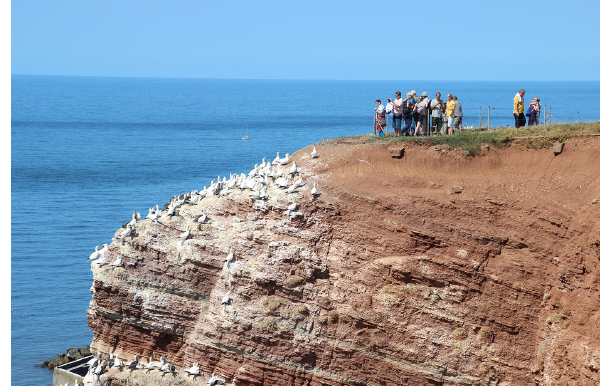
Figure 1. Breeding colony of northern gannets on the island of He- ligoland. Photo: S. Garthe.